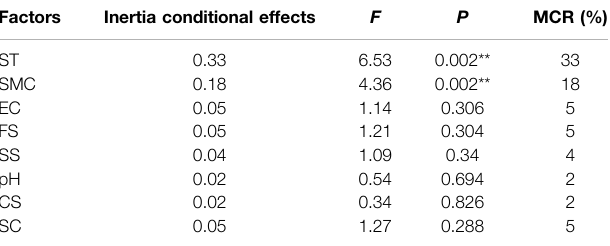
TABLE 5 | Redundancy analysis(RDA) ofthe taxa abundance data for quantifying the conditional effects of the measured environmental factors on taxa composition using forward selection with Monte Carlo permutation test. The inertia from the condition effects is used to calculate the multivariate correlation ratio (MCR), which represents the proportion of variation explained by the individual environment factors. The sum of all eigenvalues = 1.000. * p < 0.05, ** p < 0.01.SMC=soilmoisturecontent,EC=electricalconductivity, SC=soil clay, SS = soil silt, FS = fi ne sand, CS = coarse sand, ST = soil